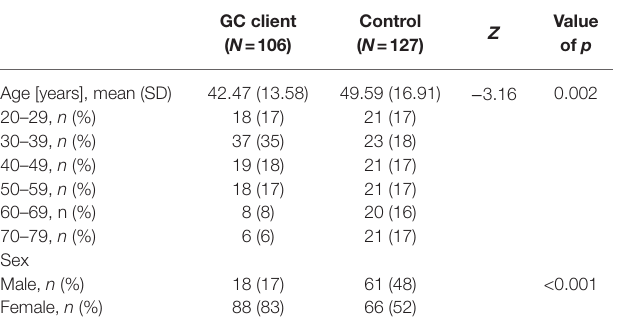
TABLE 2 | Age and sex distribution of the GC client and control groups.